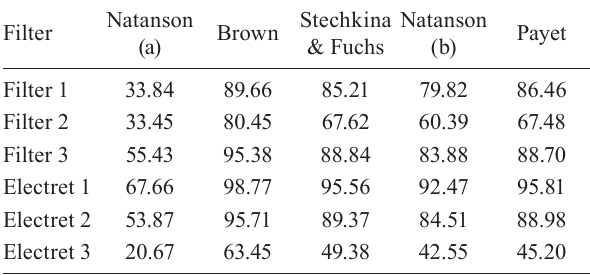
Table 5 Mass filtration efficiencies obtained using various correlations for diffusional